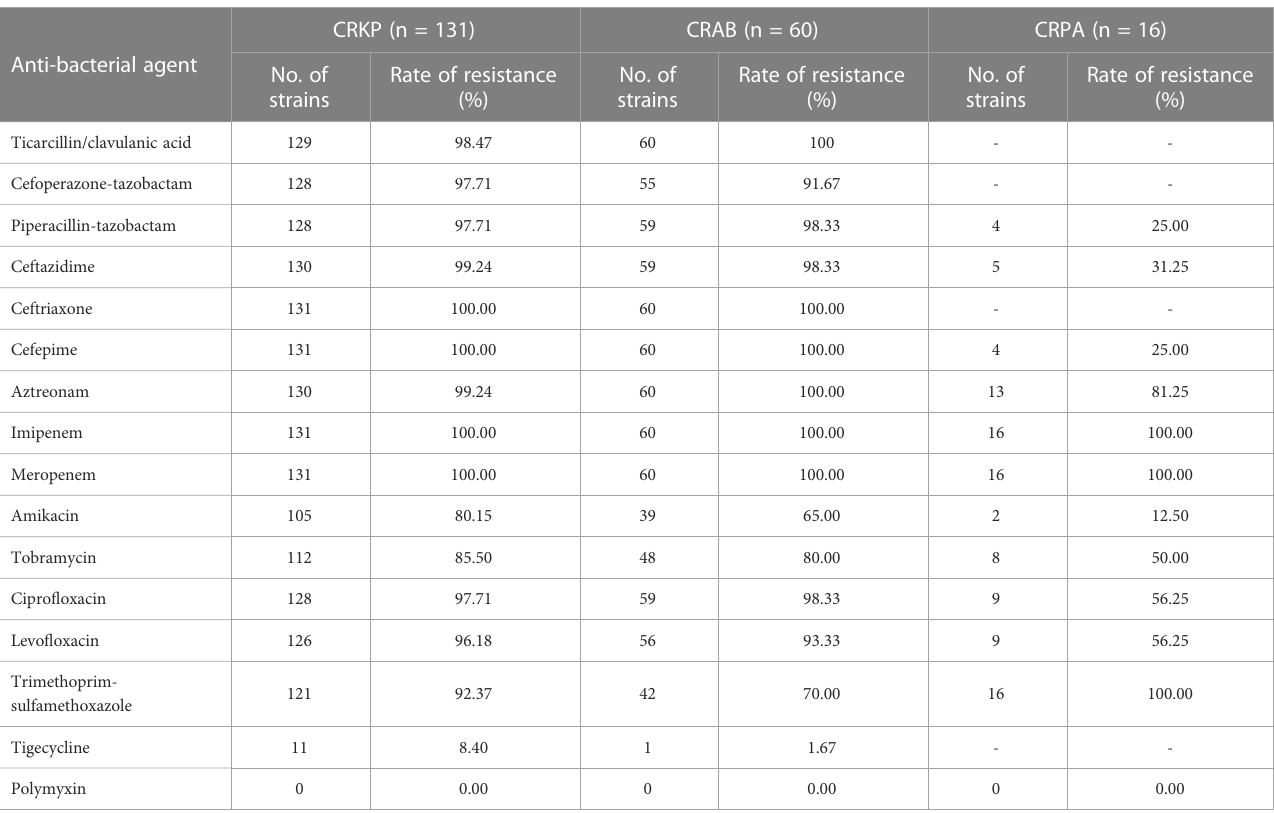
TABLE 3 Antibiotic susceptibility test results of the main types of CR-GNB.